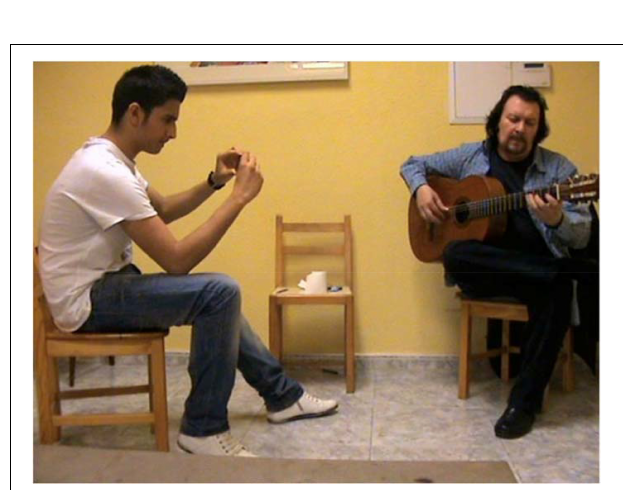
FIGURE 5 | Apprentice Flamenco R records a video on his mobile of his teacher’s